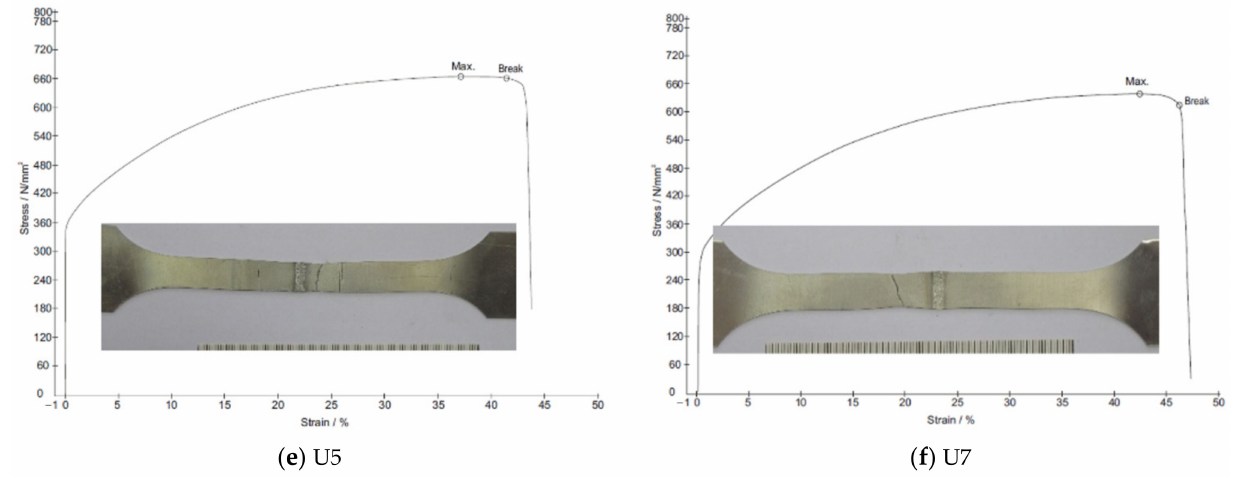
Figure 9. Stress–strain curve for U1, U2, U3, U4, U5, U7. The U1 sample cracked at the welded joint, and its elongation value was the lowest if compared to other samples, being 28.8225%. The U2 sample reached the value of a tensile strength of R m = 630,274 N/mm 2 and elongation of A = 47.1025%, which was close to the